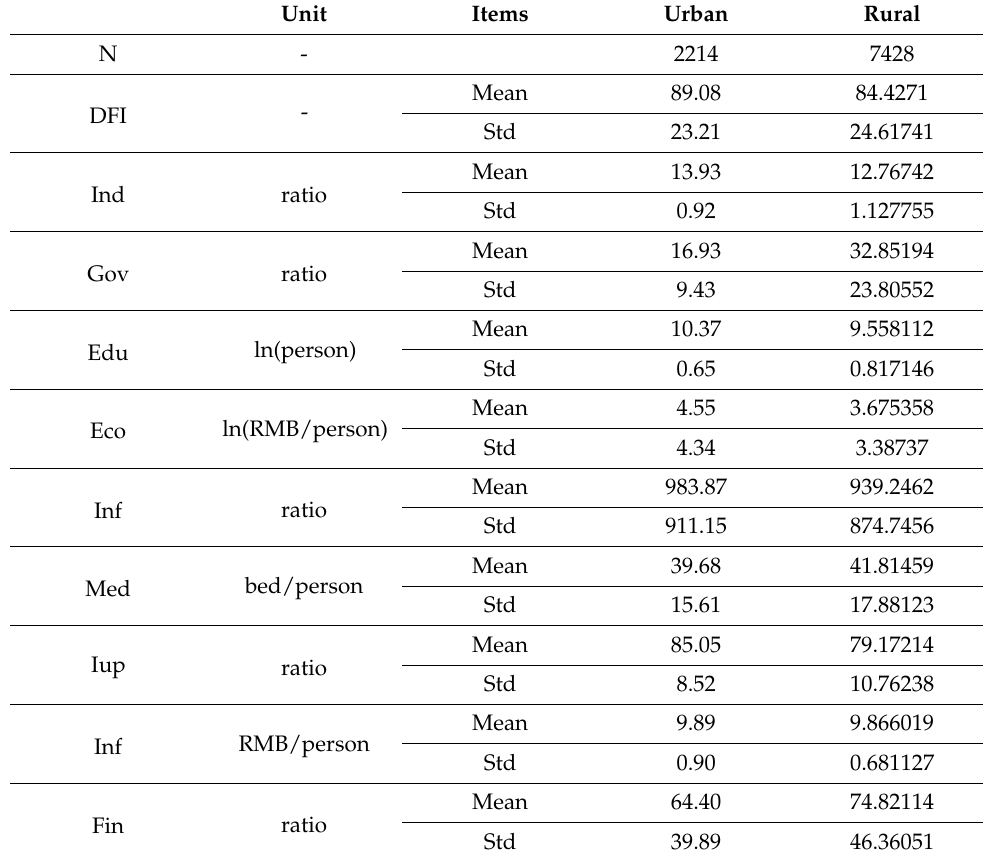
Table 2. Descriptive